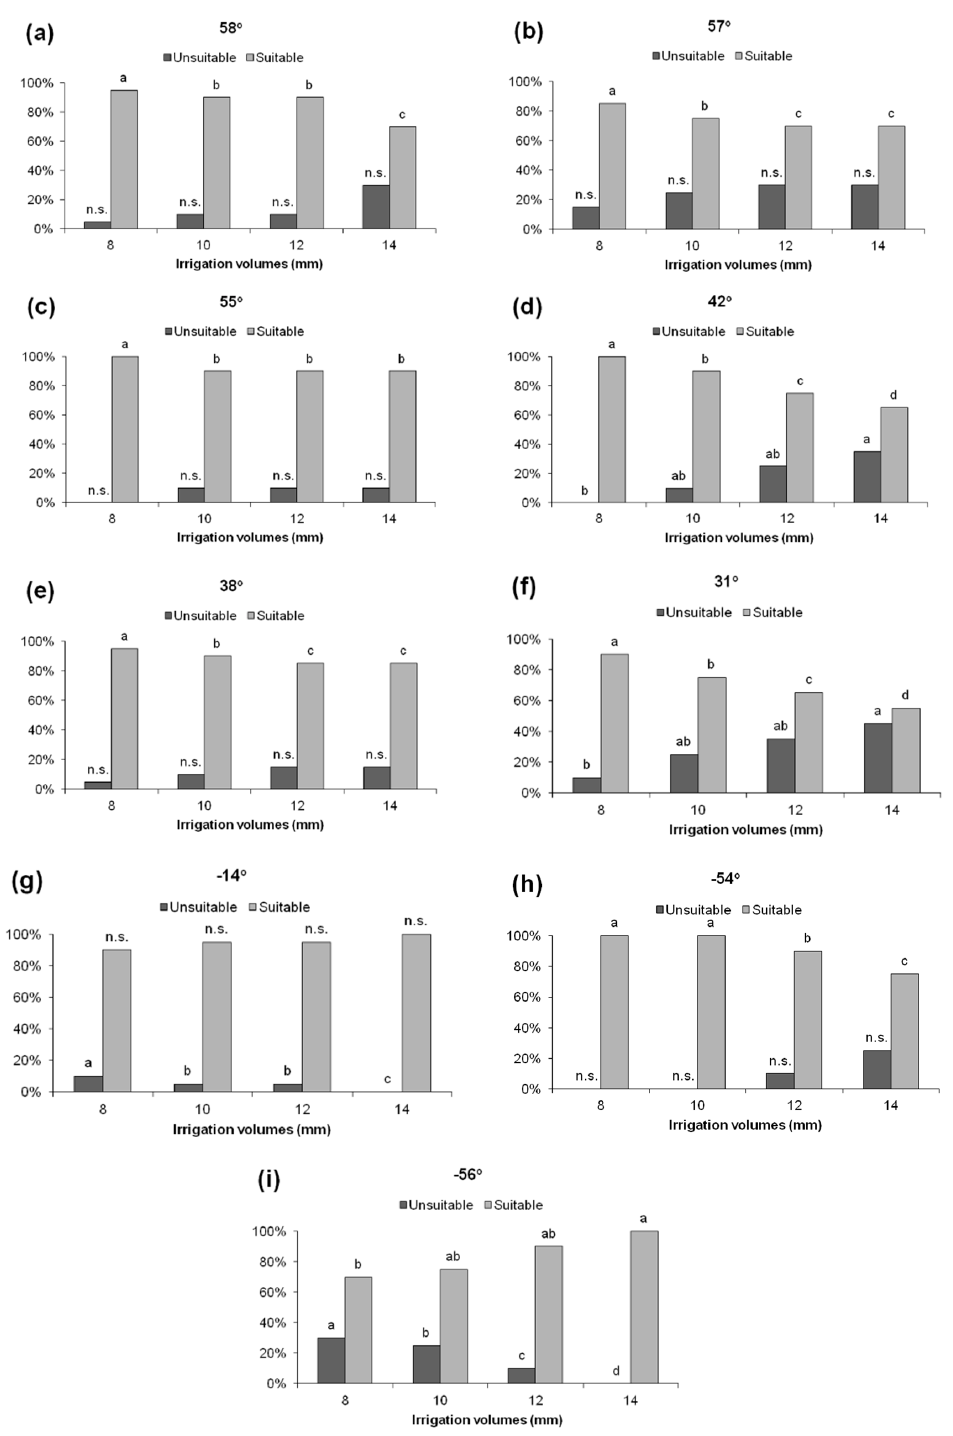
Figure 5. Effect of irrigation volume at each mean leaf angle on the root system quality (%) of